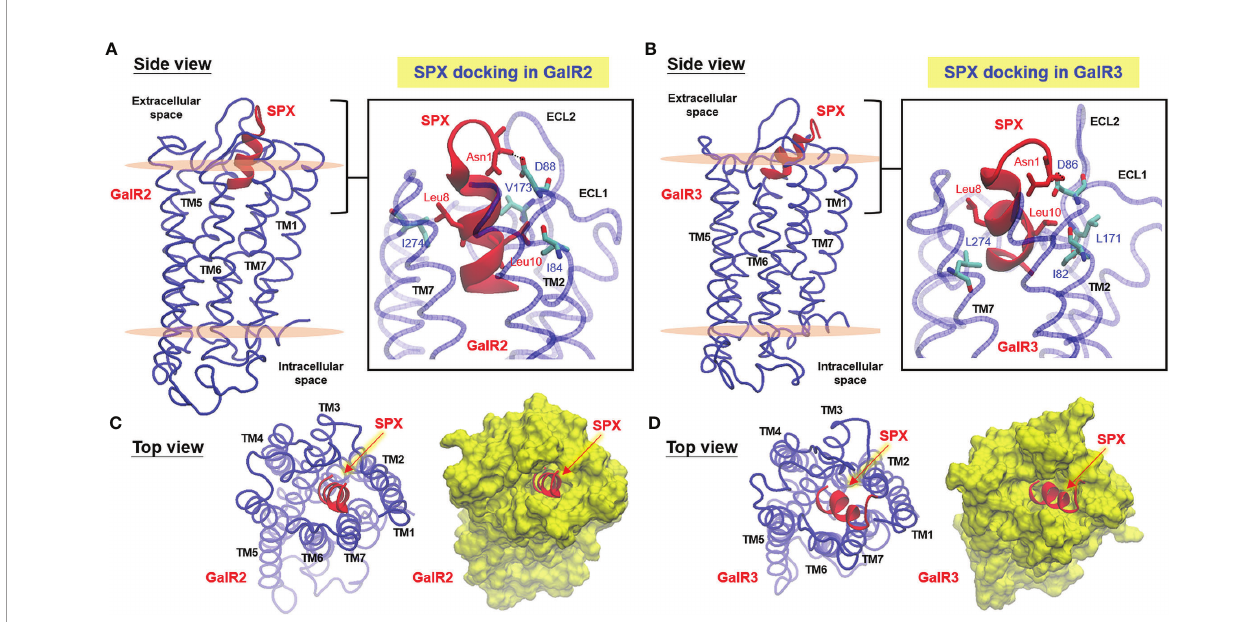
FIGURE 2 | Docking models for SPX binding with mouse GalR2 and GalR3. Side view of homologous modeling of mouse GalR2 (A) and GalR2 (B) within an asymmetric POPC/POPE lipid bilayer with MD simulation of ligand binding by mouse SPX. Molecular interactions in the well-conserved contact sites in SPX (Asn 1 , Leu 8 , and Leu 10 ) with the residues in GalR2 (Ile 84 , Asp 88 , Val 173 , and Ile 274 ) and GalR3 (Ile 82 , Asp 86 , Leu 171 , and Leu 274 ) are presented in the blow-up view close to the surface in the inset of (A, B) , respectively. Insertion of the helical region of SPX into the central binding pocket formed by clustering of TMD 1 – 7 of GalR2 (C) and GalR3 (D) could also be noted in the top view of the respective docking models. The helical model of SPX deduced by NMR is marked in red and the corresponding structures for GalR2/3 (including TMD 1 – 7 , ECL 1 – 3 , and ICL 1 – 3 ) are presented in blue for the ribbon plot or in yellow for the surface plot of the respective models. Meanwhile, the upper and lower surface of the lipid bilayer in the side view of the docking models are presented in pink